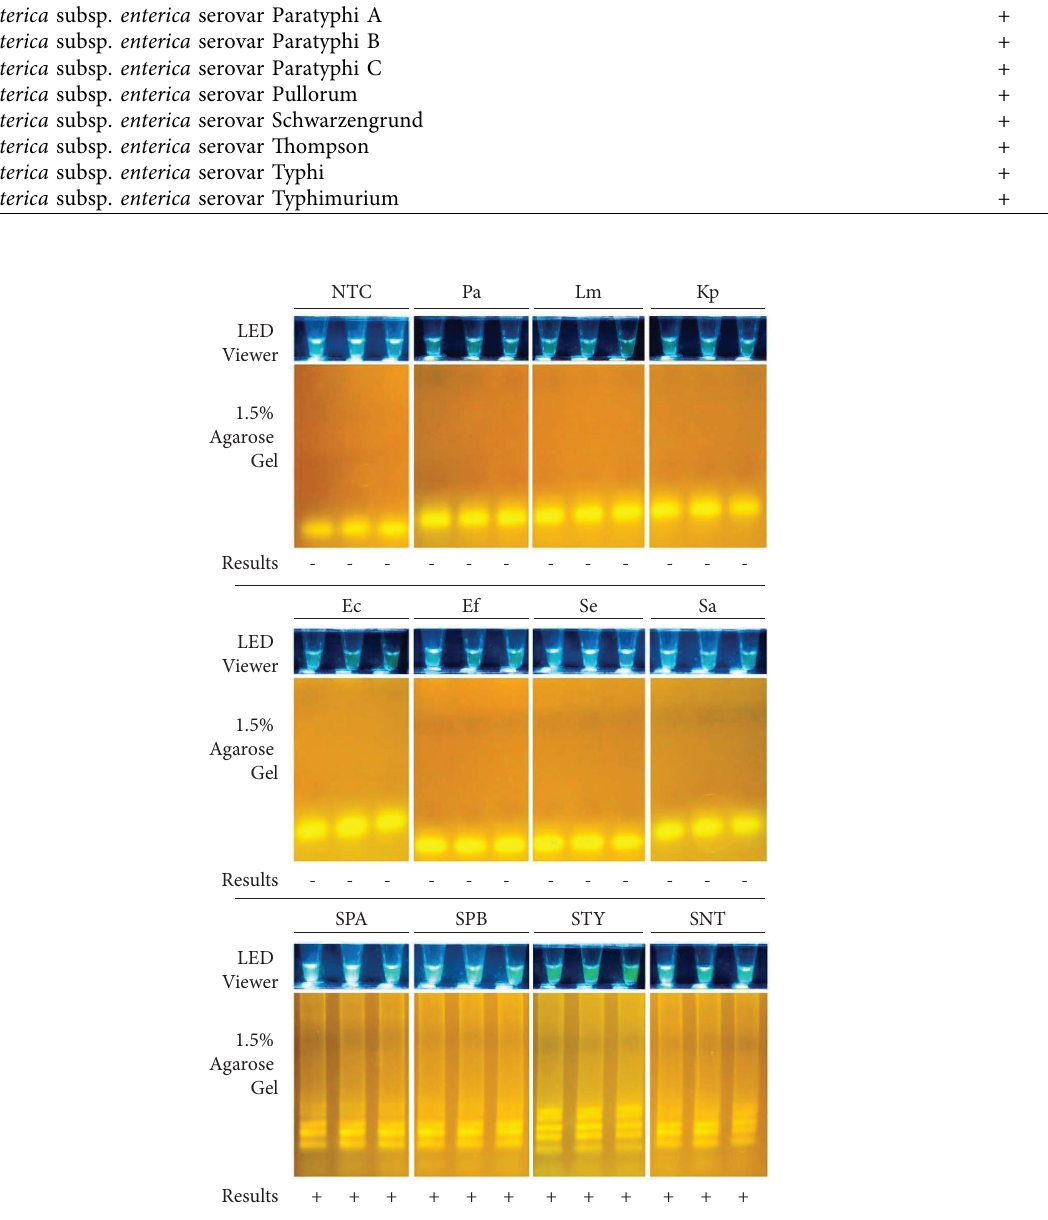
Figure 8: Assay specifcity. Sample (2.5 μ L) was added to 10 μ L reagent mix then incubated at 65 ° C for 60 minutes, 80 ° C for 2 minutes, and cooled to 4 ° C for 10 minutes using T100 Termal Cycler (S/N 621BR14432; Bio-Rad Laboratories, Inc., CA, USA). Results were viewed using the EasyViewTM LED Transilluminator (Manila HealthTek, Inc., Marikina, Philippines) which has a blue LED light and yellow plastic gel flter, and through agarose gel electrophoresis (1.5% agarose, 135V for 25 minutes). Salmonella enterica subsp. enterica positives appear bright yellow green. Positive control panel includes the following: SPA- Salmonella enterica sv. Paratyphi A (typhoidal), SPB- Salmonella enterica sv. Paratyphi B (typhoidal), STY- Salmonella enterica sv. Typhi (typhoidal), and SNT- Salmonella enterica sv. Typhimurium (nontyphoidal). Negative control panel includes the following: Pa– Pseudomonas aeruginosa , Lm– Listeria monocytogenes , Kp– Klebsiella pneumoniae , Ec– Escherichia coli , Ef– Enterococcus faecalis , Se– Staphylococcus epidermidi s (Gram-positive bacteria), and Sa– Staphylococcus aureus . Samples were assayed in triplicate. All images were taken using a Canon EOS 750D camera. Interpretation of results are as follows: (+)–Positive using the LED transilluminator and positive in 1.5% AGE; ( − )–Negative using the LED transilluminator and negative in 1.5%